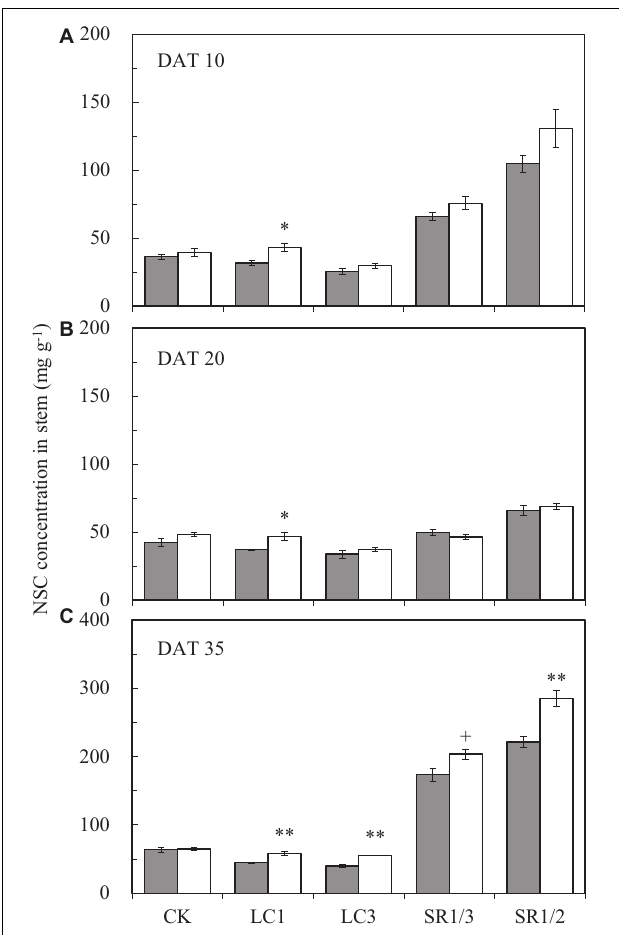
FIGURE 5 | The NSC concentration in stem of WYJ27 at DAT10 (A) , DAT20 (B) , and DAT35 (C) affected by elevated CO 2 and different source-sink treatments in 2017. Each bar in the figure represents the mean values across three plots for ambient CO 2 (aCO 2 , filled square) or elevated CO 2 (eCO 2 , aCO 2 + 200 ppm, unfilled square); vertical bars represent standard error ( n = 3). CK, no leaf cutting or spikelet removing; LC1, cutting off the flag leaf; LC3, cutting off top three leaves; SR1/3, removing one branch in every three branches of a panicle; SR1/2, removing one branch in every two branches of a panicle. DAT, day after source-sink treatment. ** P < 0.01, * P < 0.05, + P <